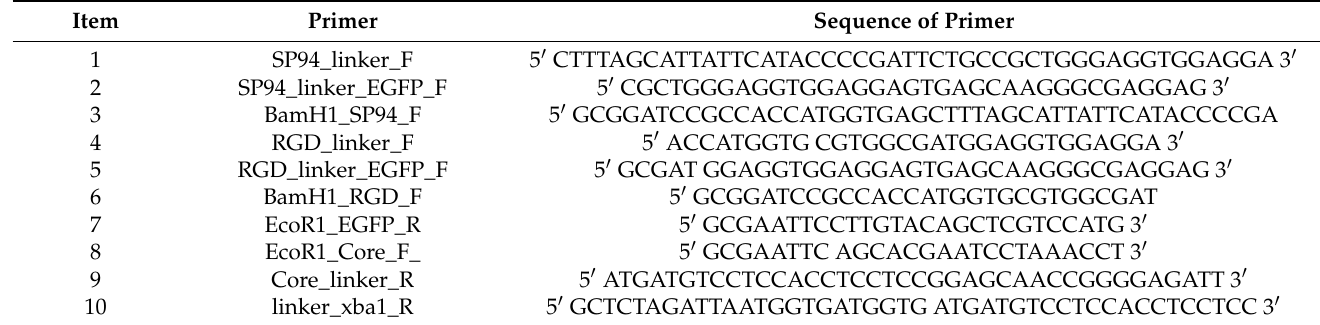
Table 1. List of primers used in sequential PCR to build the two